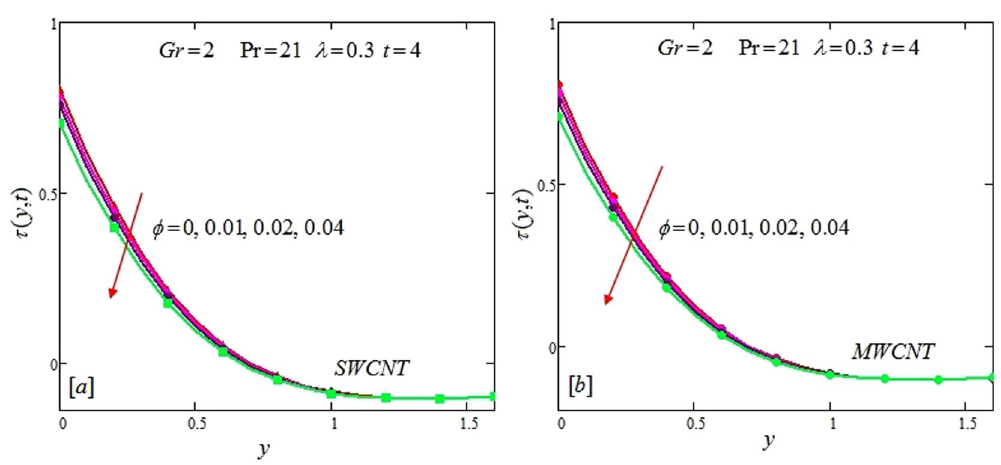
Figure 10. Shear stress profiles for single and multiple wall CNTs for different values of volume fraction of